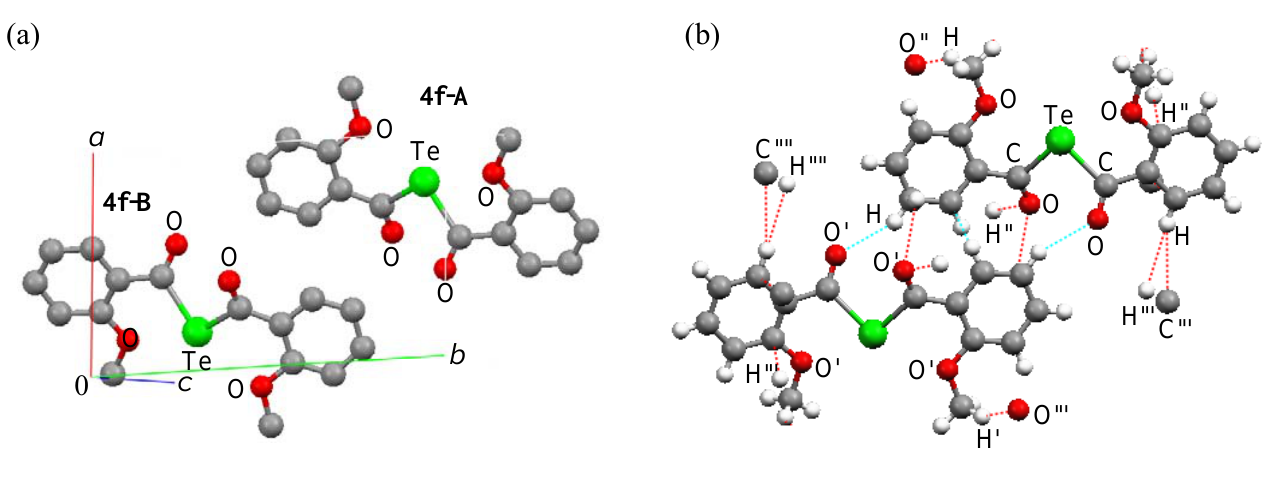
Figure 3. (a) Packing and (b) intermolecular short contacts of (2-MeOC view down to c -axis. Green, red, yellow and gray balls are tellurium, oxygen, sulfur and carbon atoms, respectively. For (a), hydrogen atoms are omitted for clarity and molecules 4f-A and 4f-B are enantiomorphic with each other. For (b), red and light blue dotted lines show intermolecular short contacts.